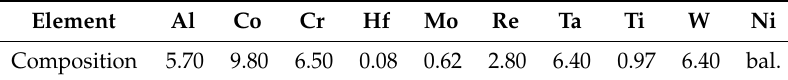
Table 1. Chemical composition of CMSX 4 powder (induction coupled plasma atomic emission spectroscopy data) in wt.